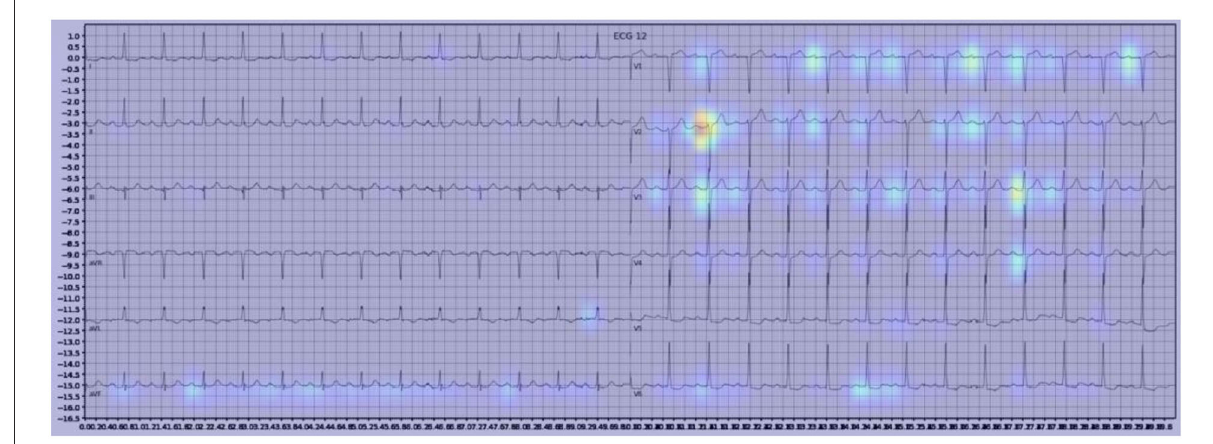
FIGURE6 Example of an activation heatmap for an ECG showing First Degree AV Block.